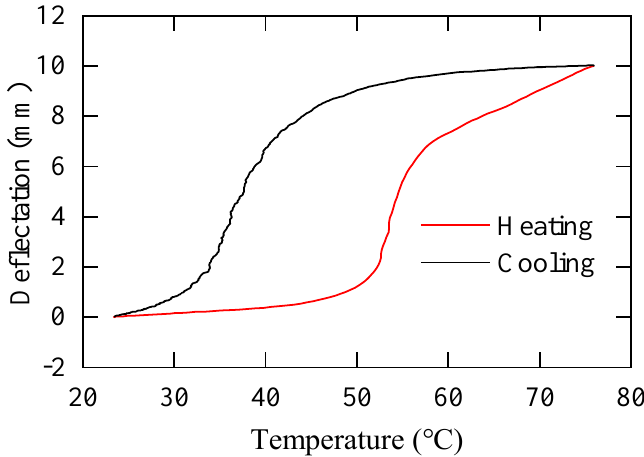
Figure 6. Deflection results for the SMA-based actuator.